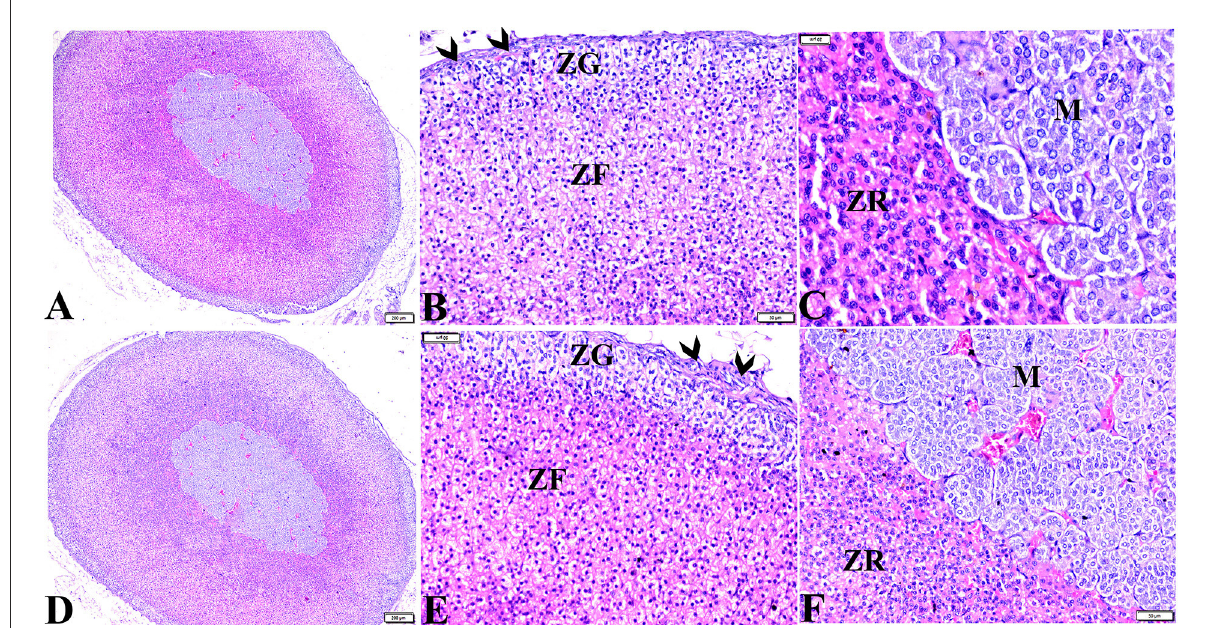
FIGURE3 Photomicrographs of adrenal gland sections from (A–C) control negative group and MT control group (D–F) indicate thin connective tissue capsules (arrowheads). A normal adrenal cortical structure comprised of ZG, ZF, and ZR cells, and a normal adrenal medulla. H&E stained. The bar size is indicated under each